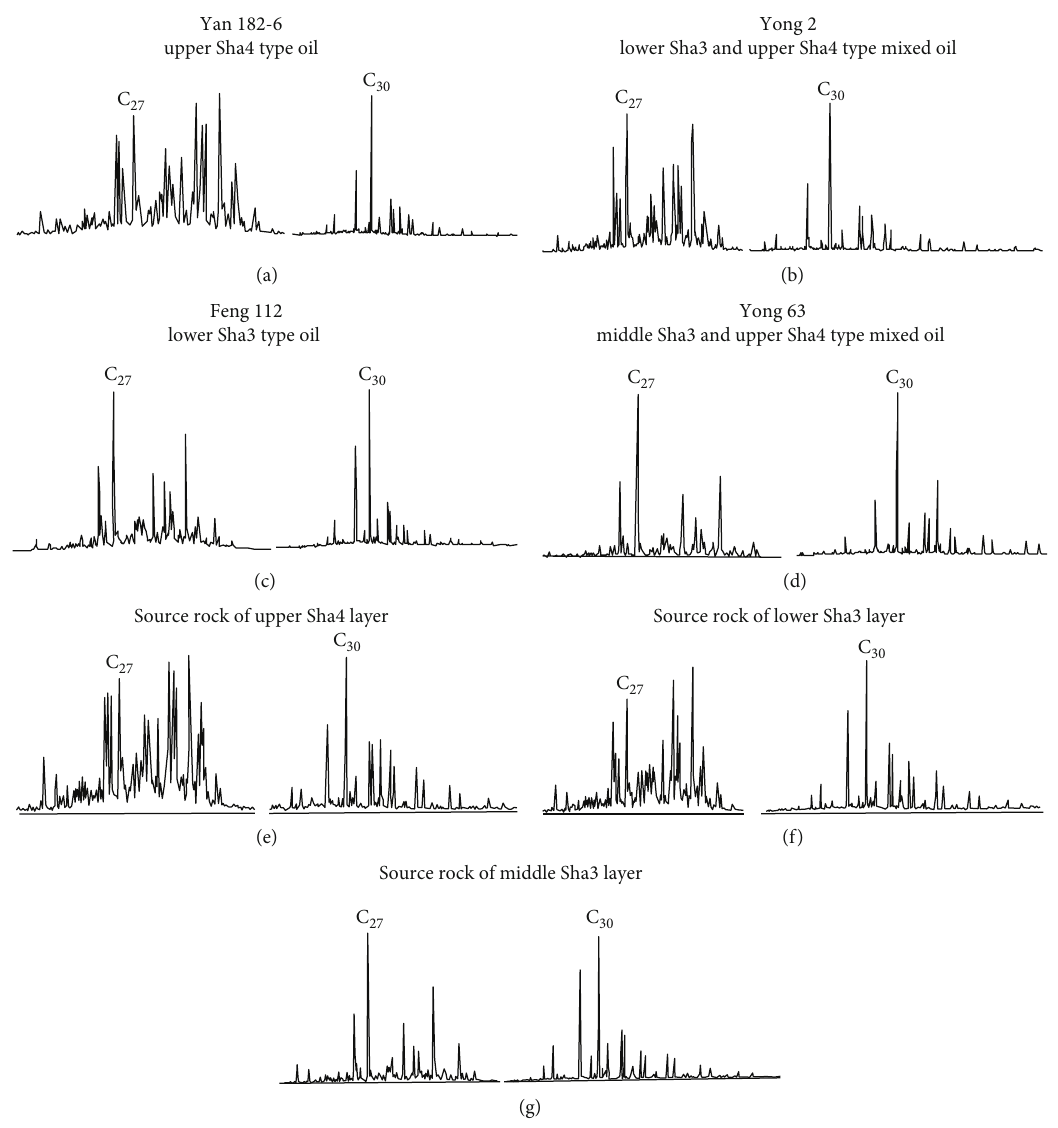
Figure 3: Sterane and terpane fi ngerprint comparison diagram of the source rocks and crude oil in the study area. (a – d) Are diagrams for crude oil and (e – g) are diagrams for source